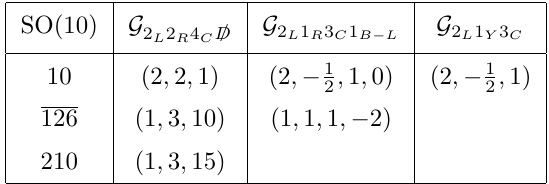
Table 2. Higgs representations that contribute to the RGEs at each stage of the symmetry breaking for the SO(10) model in section 3.2.